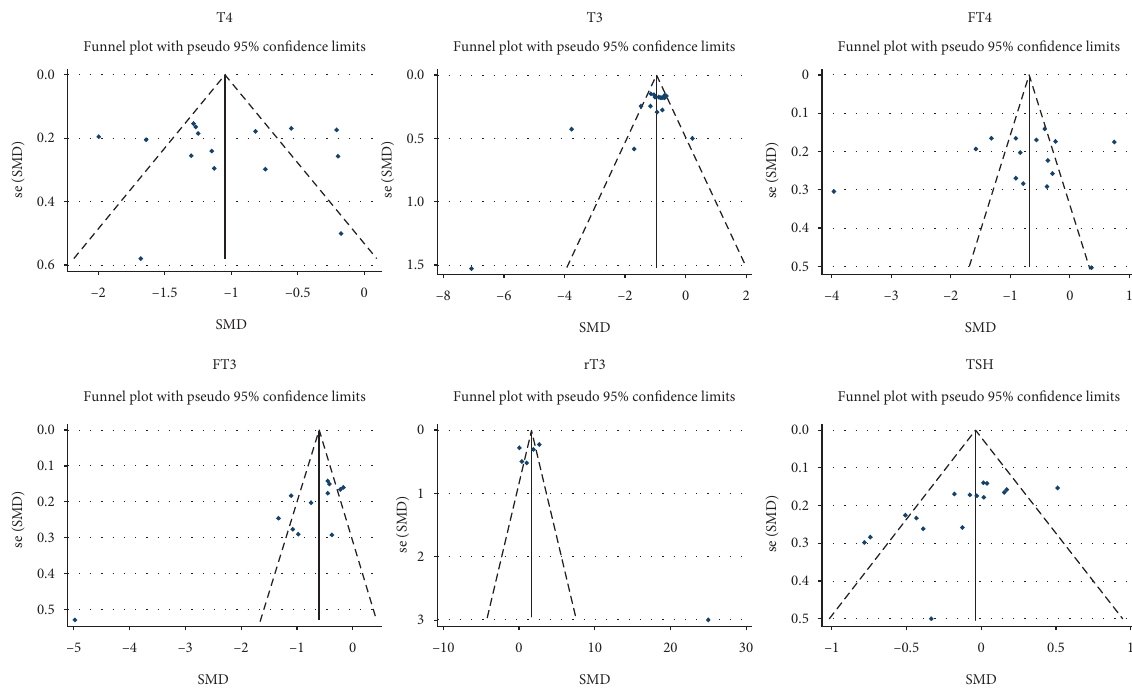
Figure 4: Funnel plot of T4, T3, FT4, FT3, rT3, and TSH compared with patients with DKA and